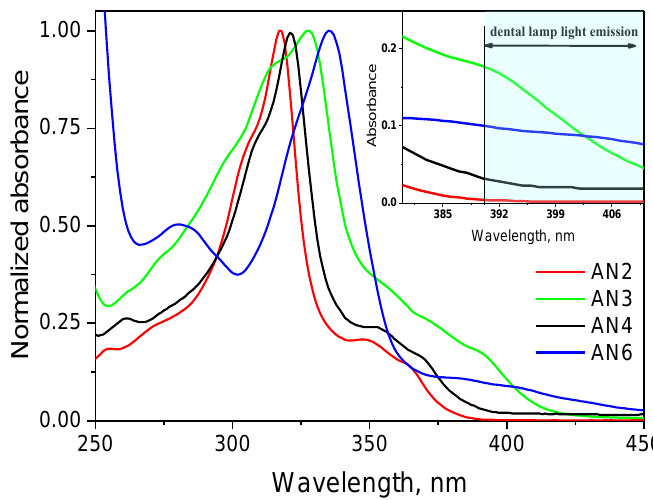
Figure 1. Normalized electron absorption spectra of selected dyes differing in structure, recorded in anhydrous ethanol; inset: fragments of the electronic absorption spectra of the dyes in the area of light emission of a dental lamp.